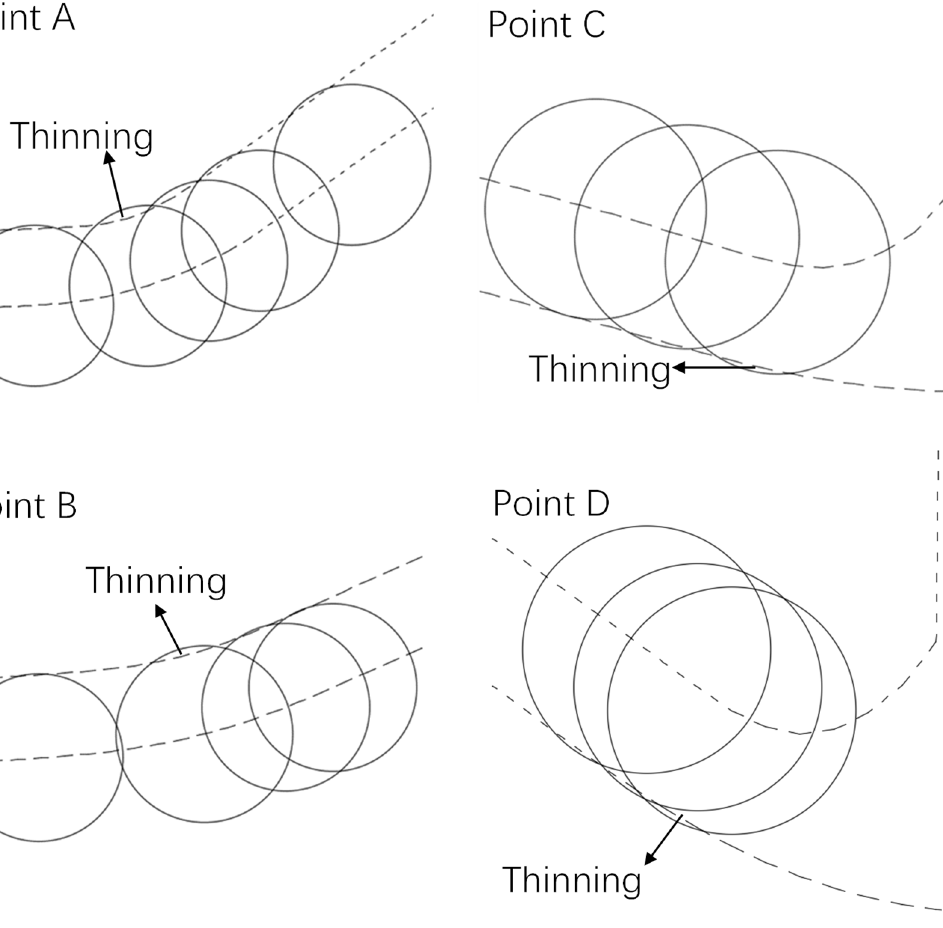
Figure 14. Plate thinning at typical points.